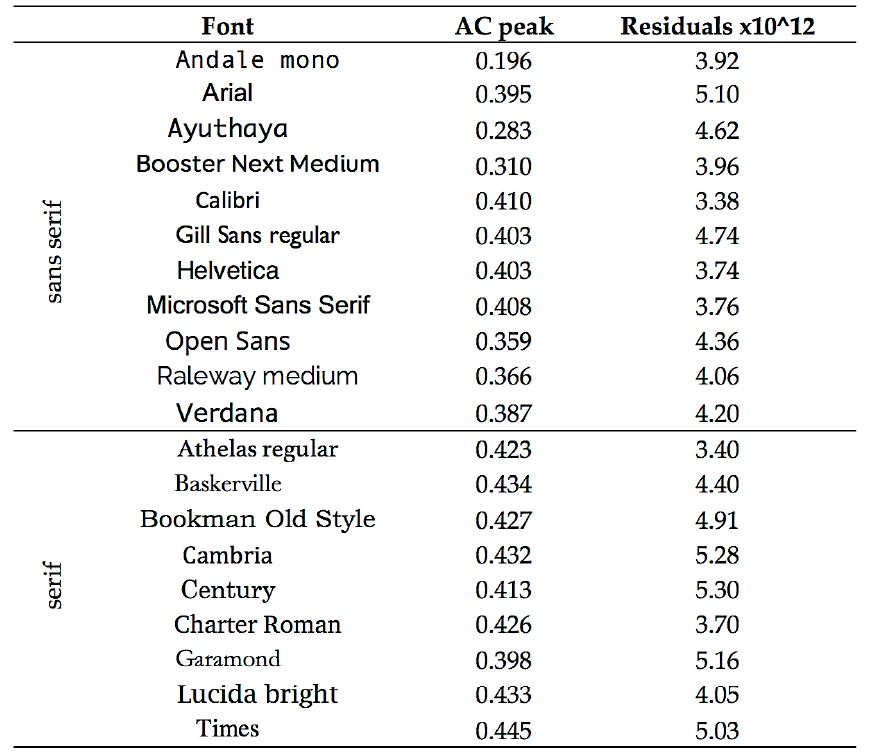
Table 1. A total of 20 fonts showing the mean of the first peak in the horizontal autocorrelation (AC peak) and the residuals after fitting a 1 / f cone to the Fourier amplitude